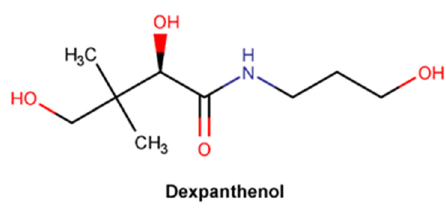
Figure 12. Chemical structure of dexpanthenol.